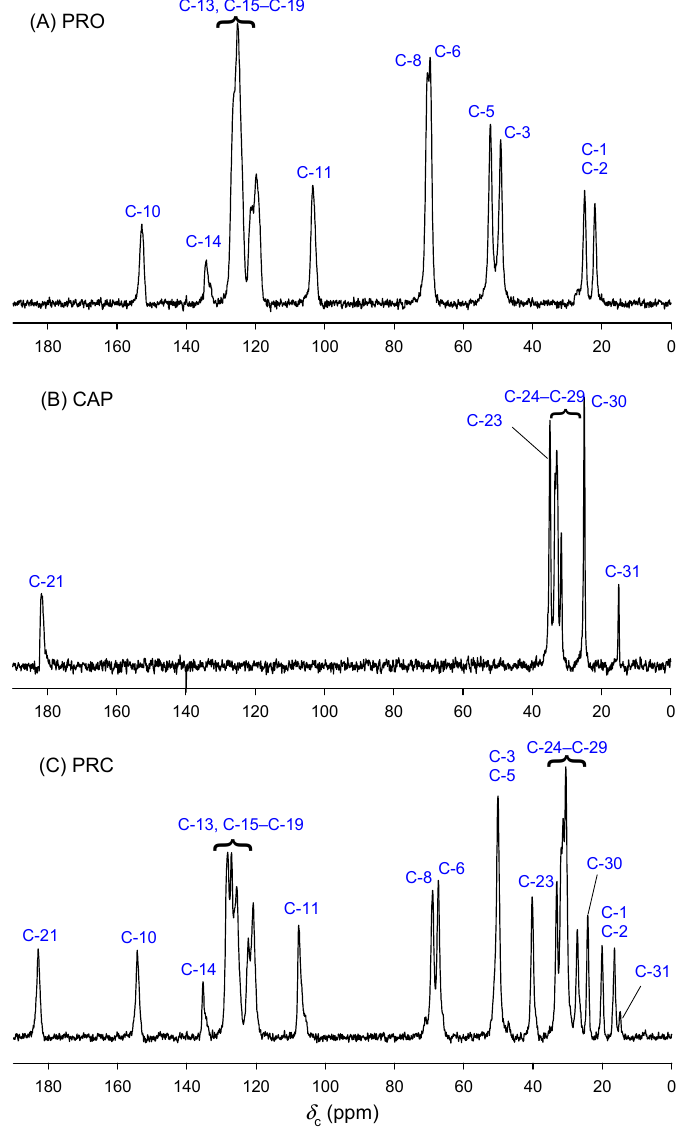
Figure 4. Carbon-13 CP MAS NMR spectra (201.12 MHz) of ( A ) PRO, ( B ) CAP and ( C ) PRC.